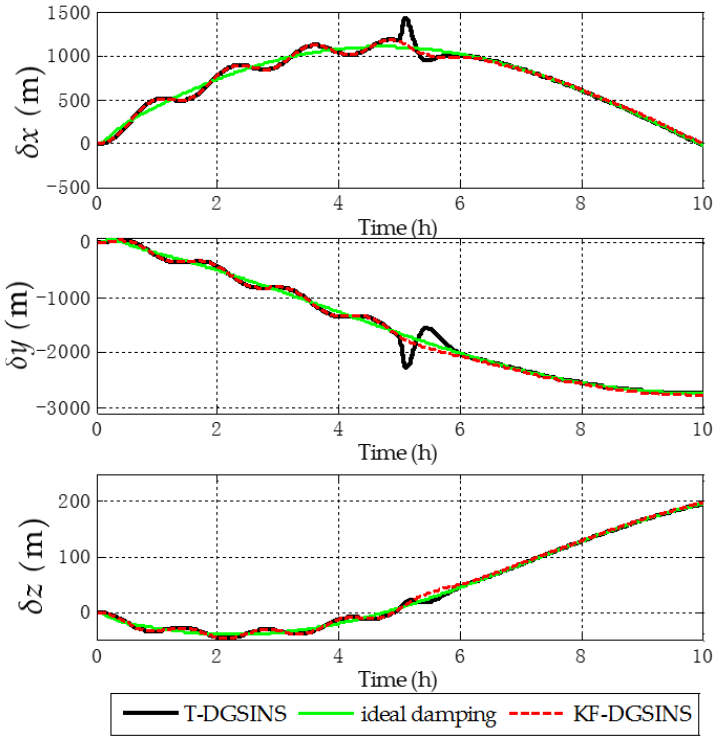
Figure 11. Position errors in e frame of the simulation results.